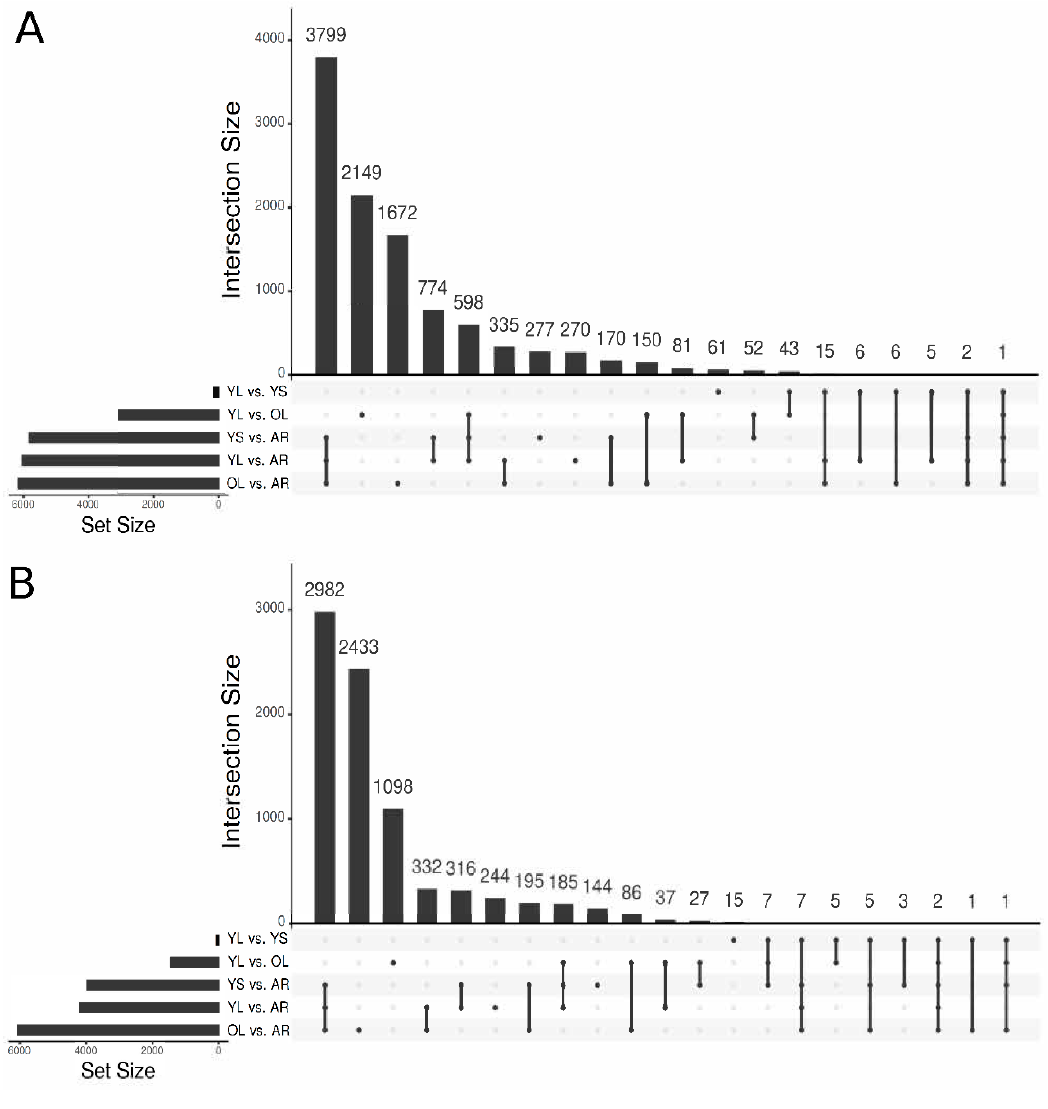
Figure 4. Di ff erential gene expression analysis. UpSetR [78] plots highlighting the intersections resulting from the di ff erentially expressed gene (DGE) analysis for the di ff erent comparisons as ( A ) log fold change > 2 indicating increased expression and ( B ) log fold change < − 2 indicating decreased expression. Set sizes indicate the total number of transcripts di ff erentially expressed for each comparison.